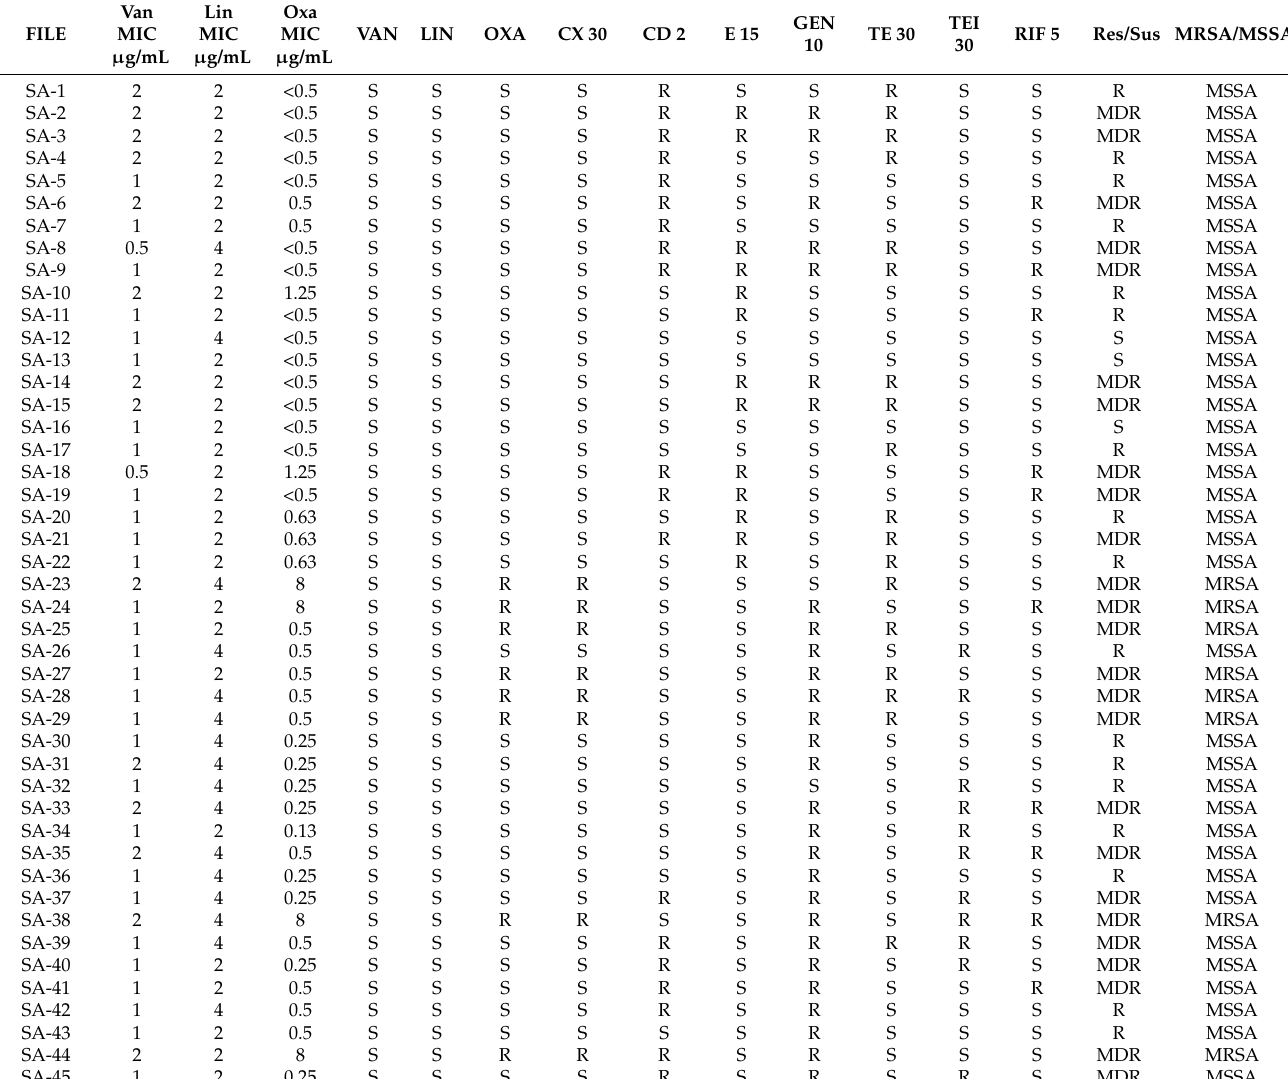
Table 2. Antimicrobial resistance profile of the S. aureus